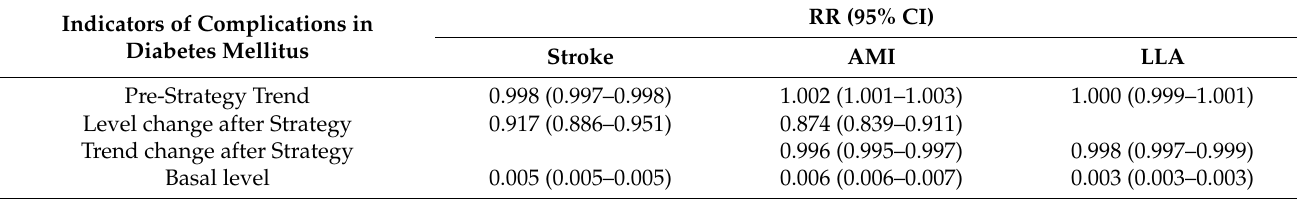
Table 2. Significant segmented regression models of the indicators related to complications. Relative risks (RRs) and 95% confidence interval (95% CI).